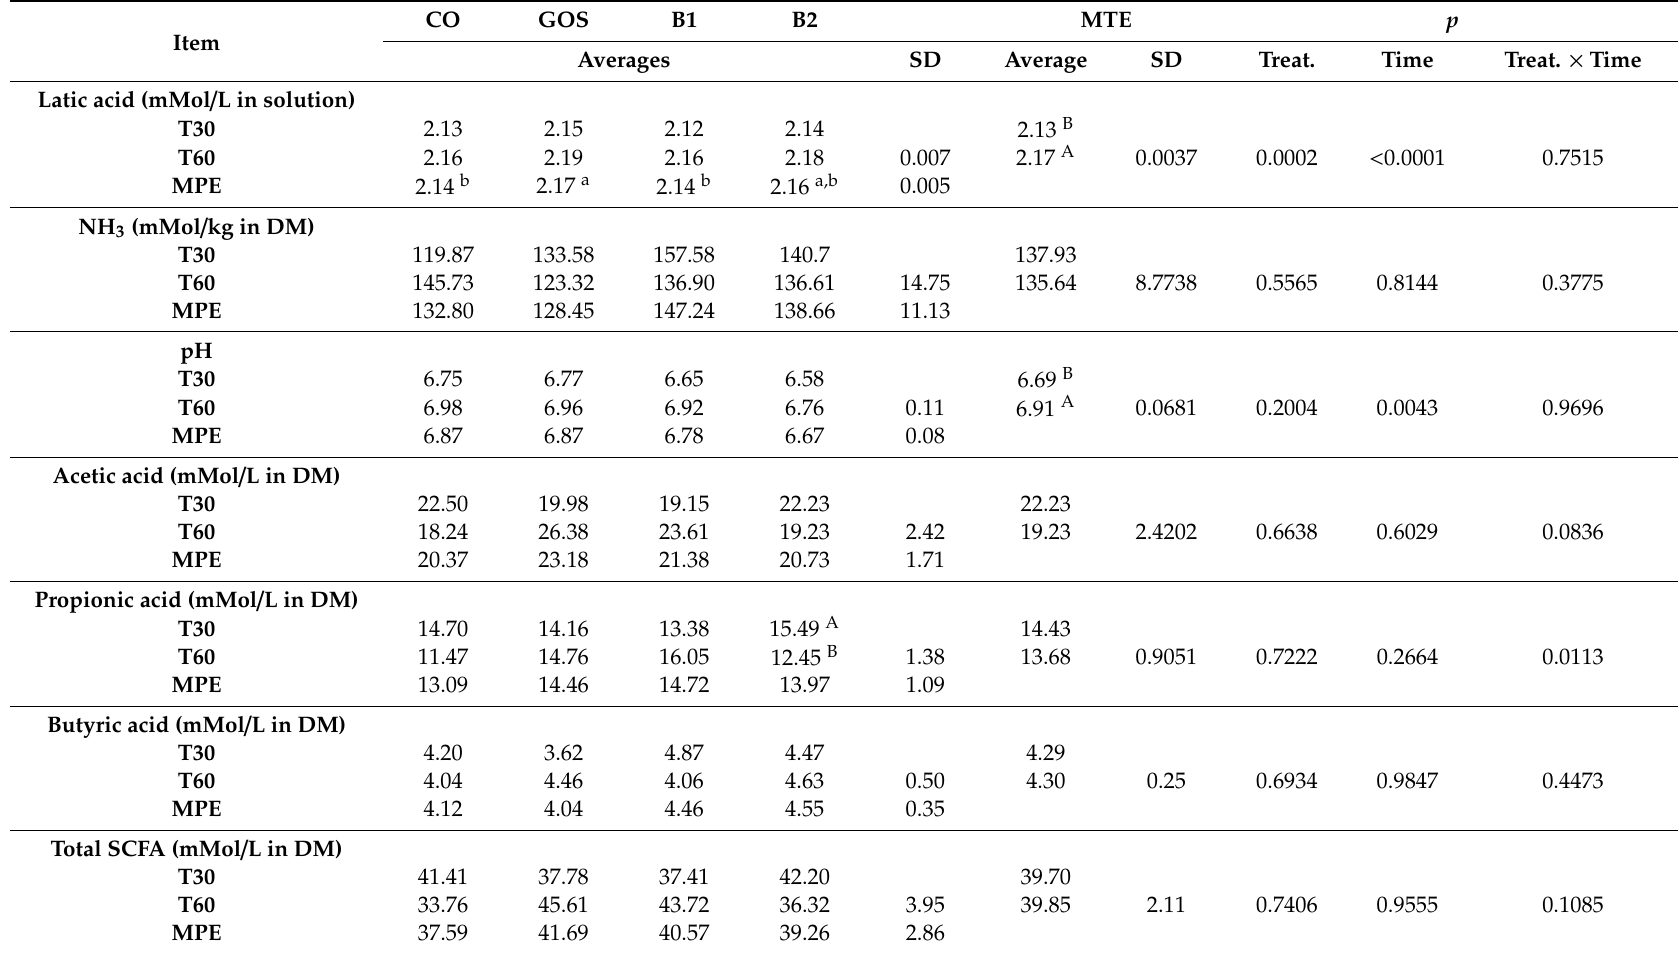
Table 2. Average concentrations of fecal and immunological fermentative products of adult dogs fed with di ff erent